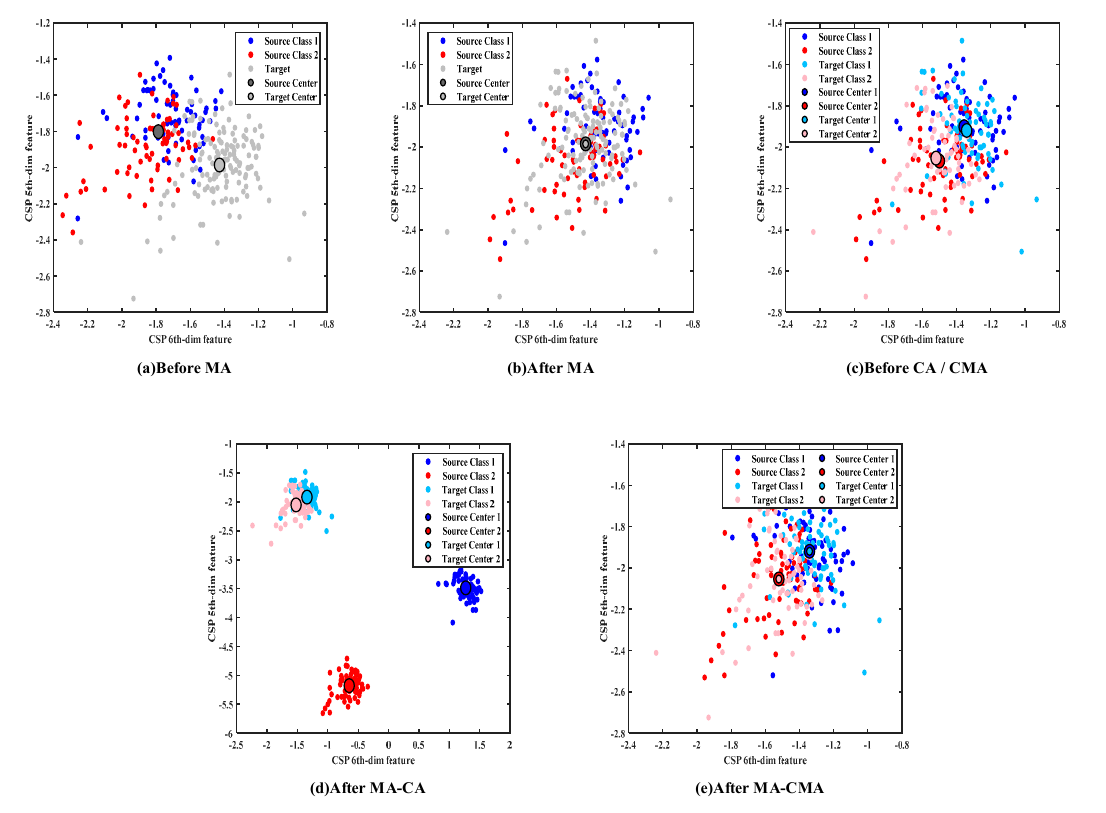
Figure 3. Visualization of data distribution during the alignment process for subject 5 on dataset 2. Data distribution ( a ) before MA, ( b ) after MA, ( c ) before CA/CMA, ( d ) after MA-CA, ( e ) after MA-CMA.